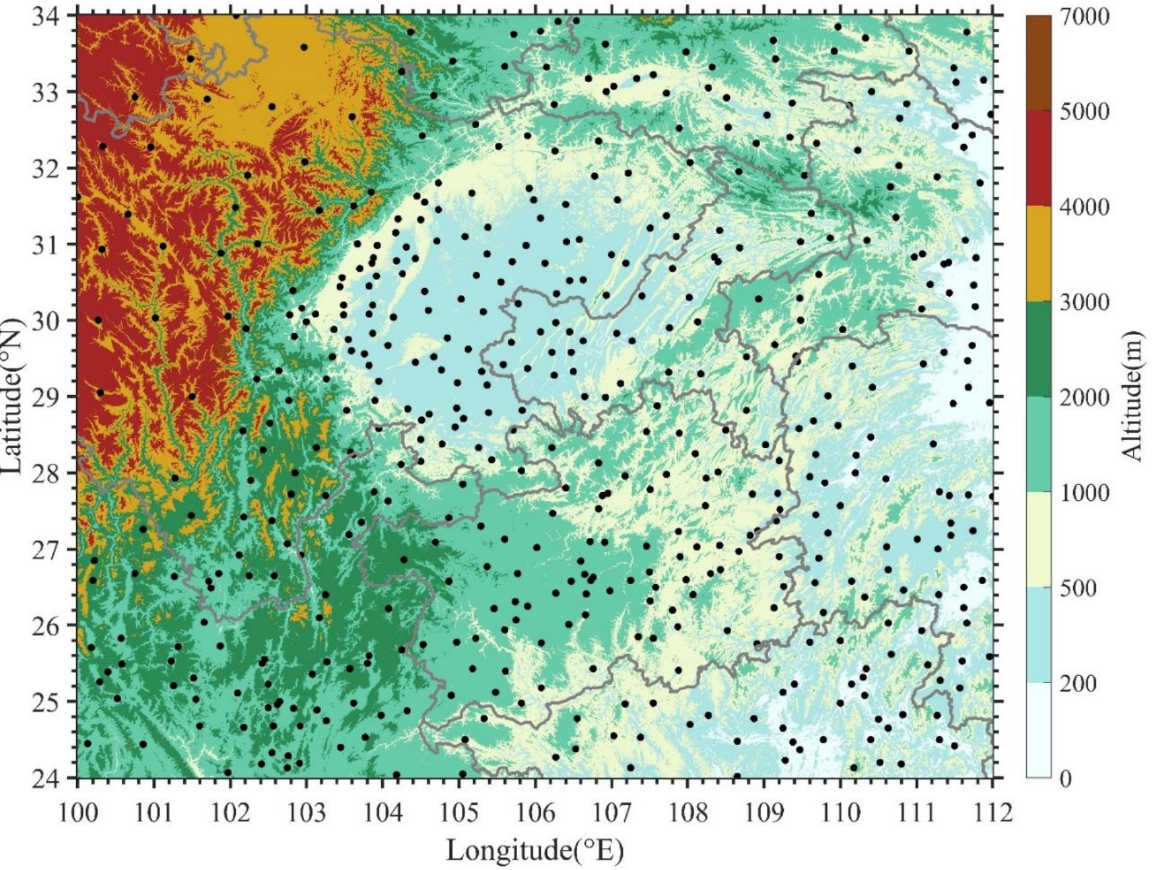
Figure 1. The topography and distribution of RGs (black dots) in the study